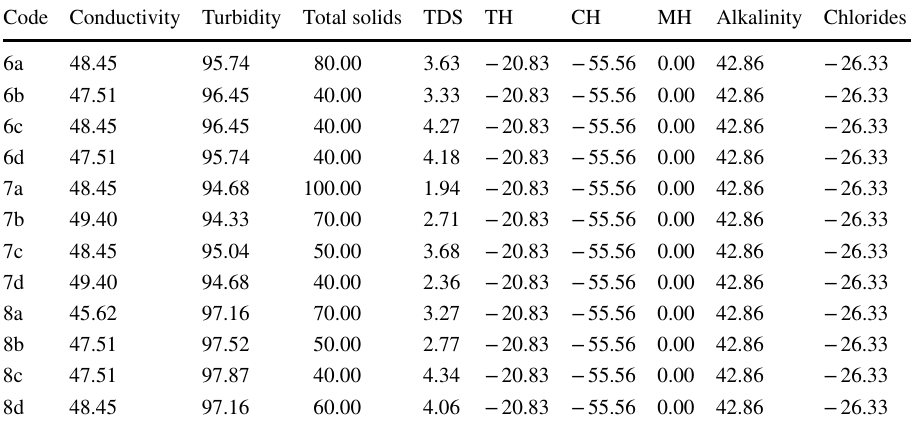
in various physicochemical parameters of surface water